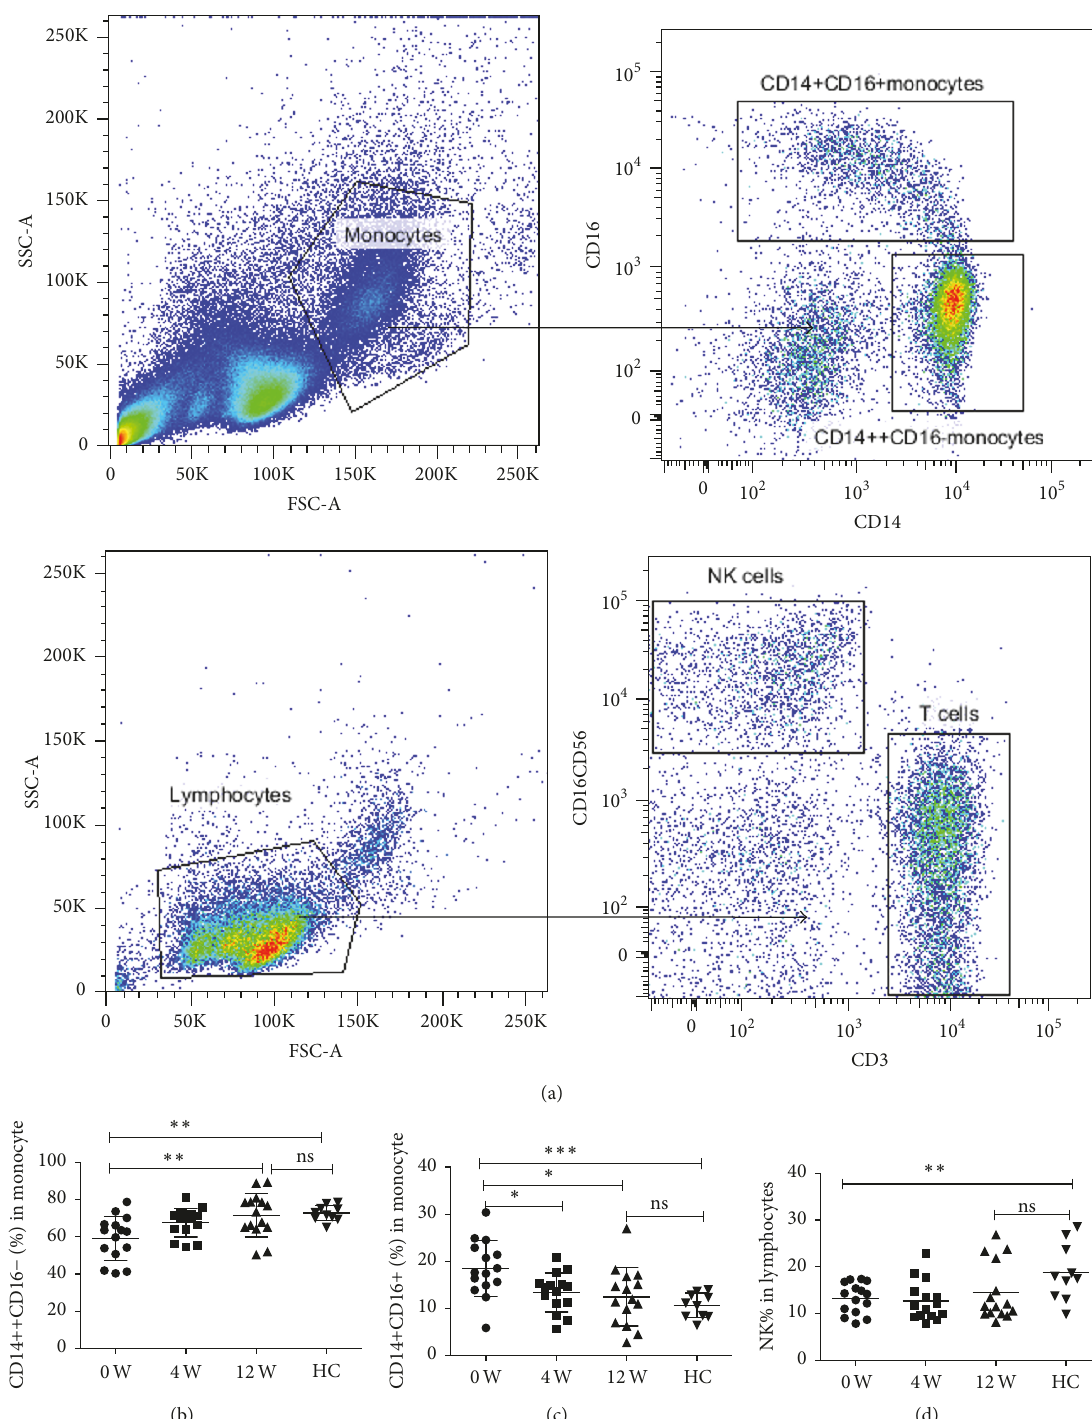
Figure 1: Dynamic changes of the frequency of monocytes subsets and natural killer cells during DAAs treatment . (a) Representative flow cytometry plots of CD14 ++ CD16 − monocytes, CD14 + CD16 + monocytes, and CD3 − CD16 + CD56 + NK cells; (b) dynamic changes of the frequency of CD14 ++ CD16 − monocytes; (c) dynamic changes of the frequency of CD14 + CD16 + monocytes; (d) dynamic changes of the frequency of CD3 − CD16 + CD56 + NK cells. ∗ 𝑝 < 0.05 ; ∗∗ 𝑝 < 0.01 ; ∗∗∗ 𝑝 < 0.001